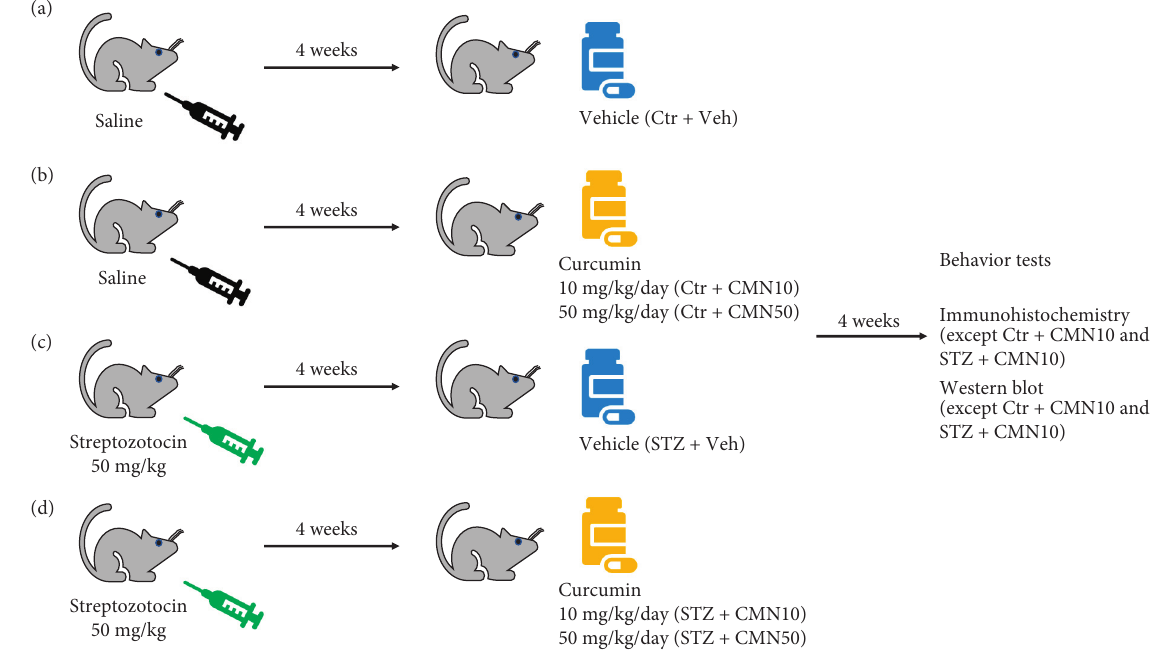
Figure 1: Simple experimental scheme. (a, b) Groups of rats were injected with saline solution at 0.9% intraperitoneally (IP). Four weeks later, they received either vehicle (Ctr +Veh), 10 mg/kg/day (Ctr+CMN10), or 50mg/kg/day of curcumin (Ctr+CMN50) orally for 4 consecutive weeks. The experiments were subsequently conducted. (c, d) Groups of rats were injected with 50mg/kg of streptozotocin (STZ) IP. Four weeks later, they received vehicle (STZ+Veh), curcumin 10mg/kg/day (STZ+CMN10), or 50mg/kg/day (STZ+CMN50) orally for 4 weeks before the start of the